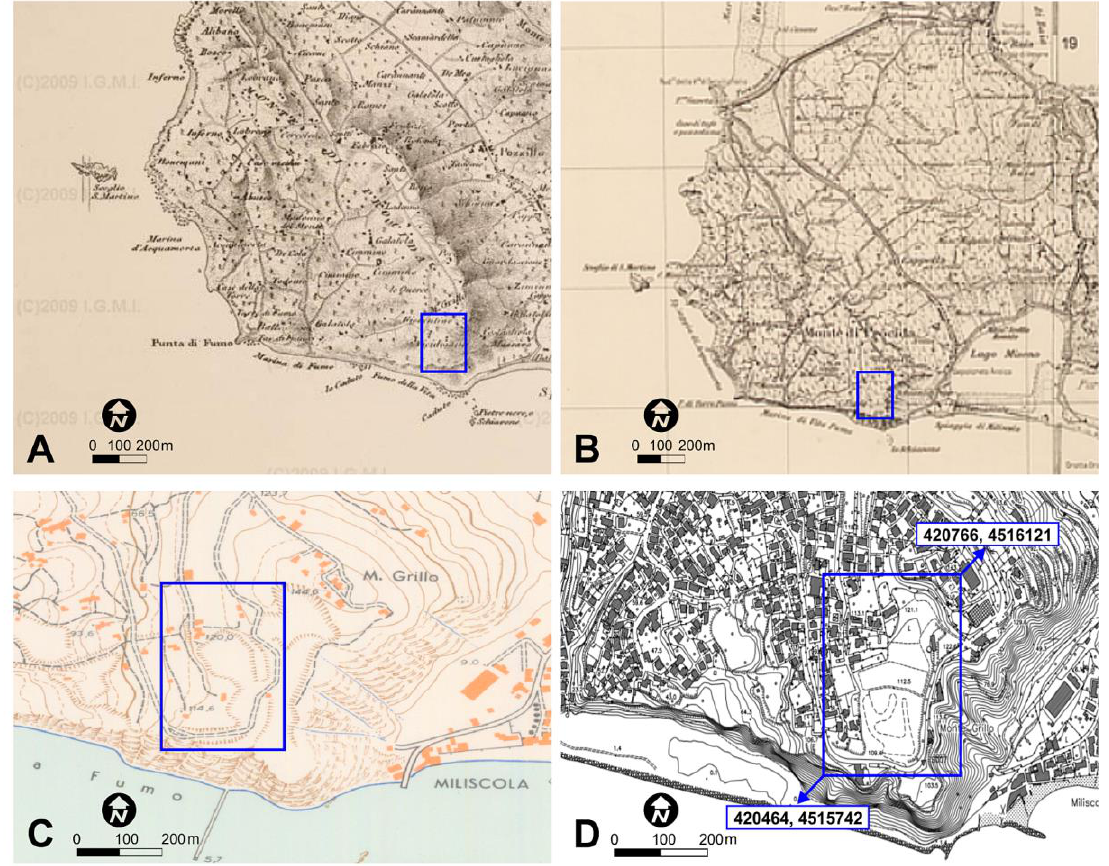
Figure 3. Comparison between topographic maps of 1870 ( A ), 1936 ( B ), 1965 ( C ), and 2004 ( D ), respectively at 1:25,000 ( B ), 1:10,000 ( A , C ), and 1:5000 ( D ) original scales. Blue polygons indicate the location of the investigated area. Coordinates are in the reference system ETRF 2000/UTM—zone 33 N.